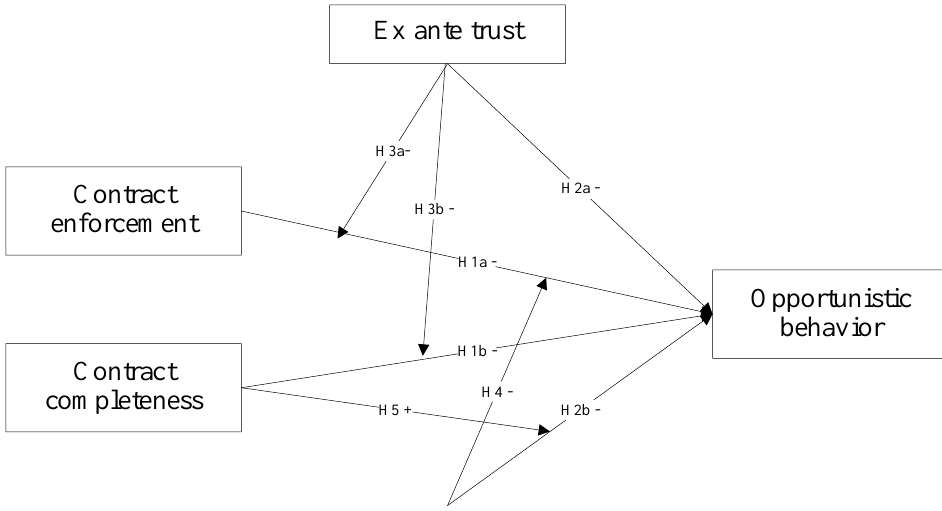
Figure 1. Theoretical framework. Note: source own elaboration.